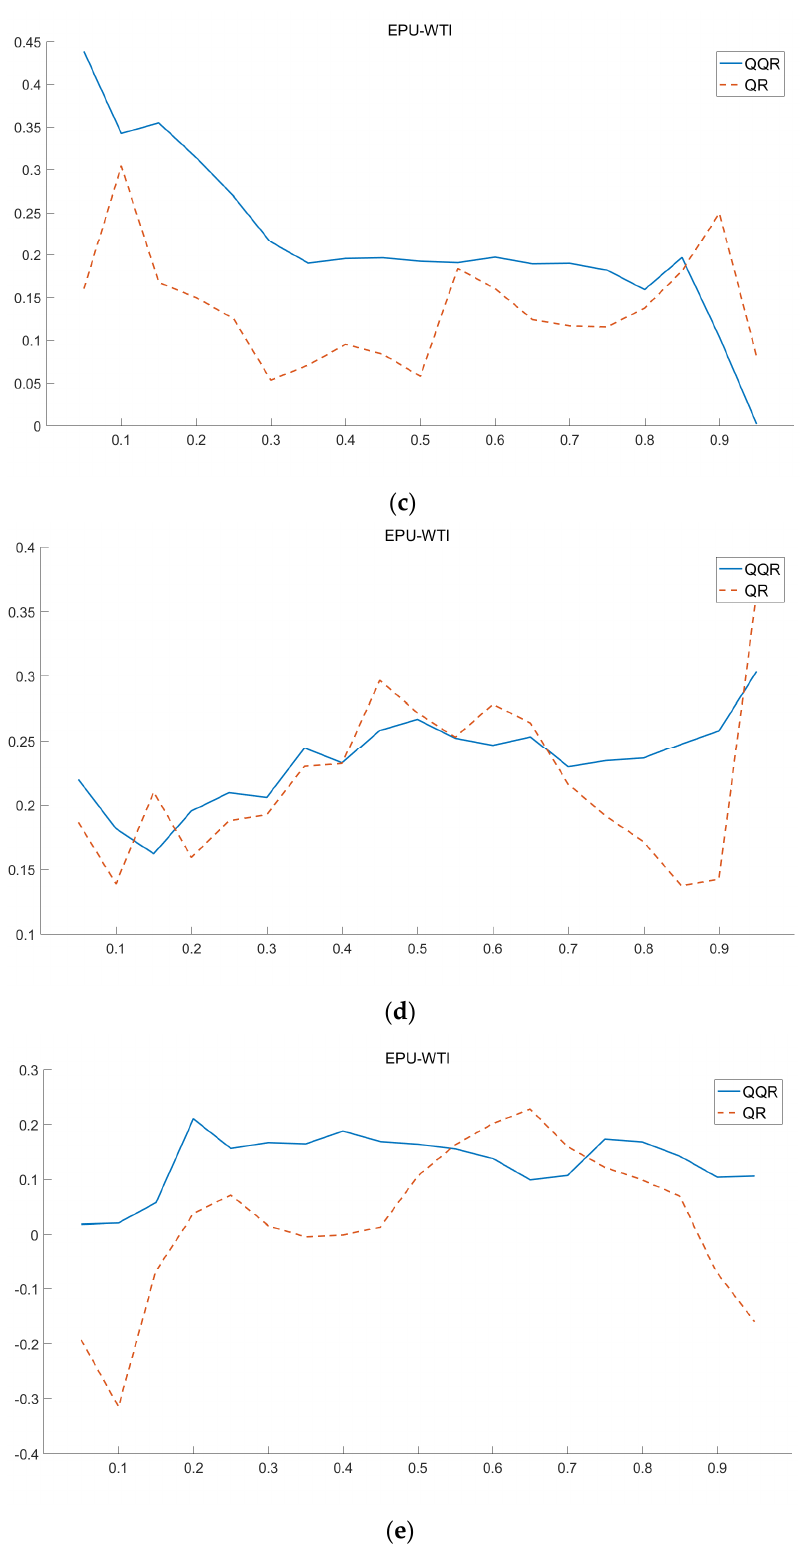
Figure 6. Comparison of impact coefficient estimates of the EPU on the WTI under QQR and Q.R. ( a ) Comparison of the impact of EPU on WTI under the Q.R. and the QQR at D1; ( b ) Comparison of the impact of EPU on WTI under the Q.R. and the QQR at D2; ( c ) Comparison of the impact of EPU on WTI under the Q.R. and the QQR at D3; ( d ) Comparison of the impact of EPU on WTI under the Q.R. and the QQR at D4; ( e ) Comparison of the impact of EPU on WTI under the Q.R. and the QQR at D5.